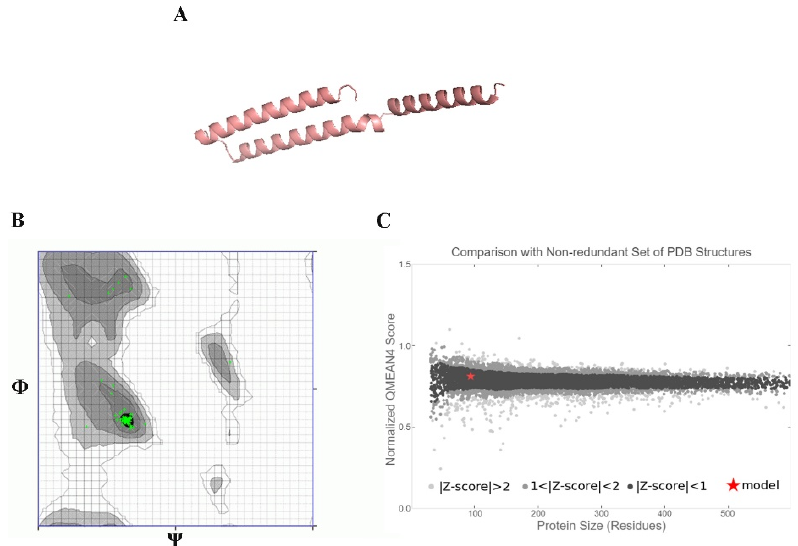
Figure 7. KAE01 EntP model obtained from AB method: ( A ) ribbon view of 3 KAE01 EntP model, ( B ) Ramachandran plot, and ( C ) qmean Z-score plot.